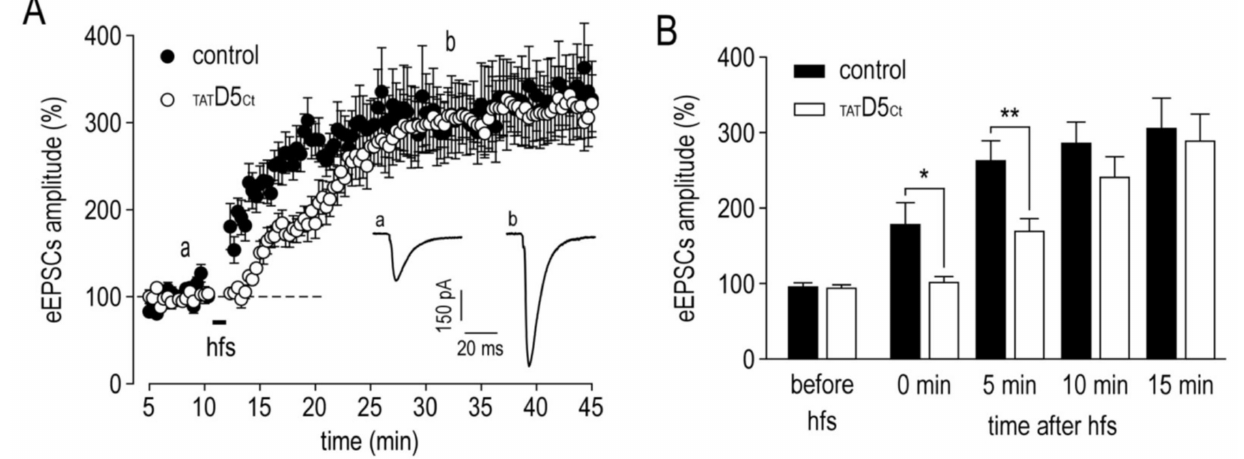
Figure 10. The disrupting peptide shifts in time the expression of long-term potentiation at CA3–CA1 synapse in hip- pocampal slices. ( A ) Pooled data showing eEPSCs amplitude versus time for all experiments in which control or disrupting peptide was added in the patch pipette. The inset shows representative traces of eEPSCs before (a) the high-frequency stimulation (hfs) and after (b) the expression of the LTP. ( B ) Summary bar graph showing pooled data for the effects of control or disrupting peptide at various time points after hfs. Data are represented as mean ± SEM normalized to the mean amplitude of eEPSCs before hfs. * p < 0.05, ** p < 0.01. Nonparametric Mann–Whitney test. Experiments in the presence of 10 µ M